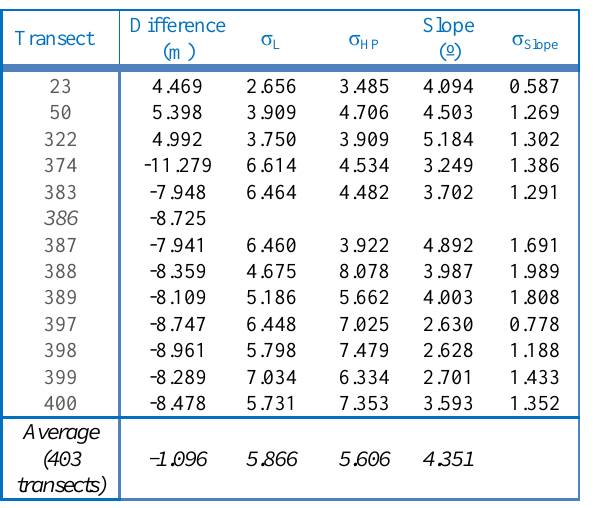
Table 1. Results obtained in transects with rejection of equality of means or medians between Landsat and HP data. Slope is related to the changes in the terrain elevation.